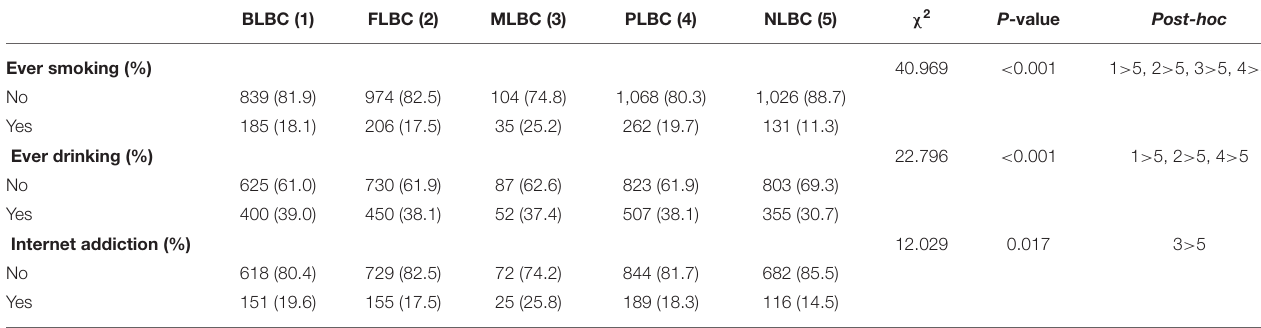
TABLE 3 | Risk behaviors by parental migration groups, n (%).